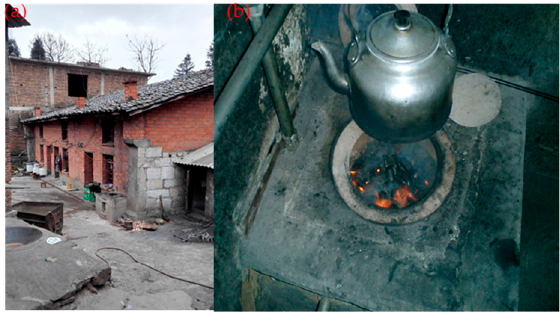
Figure 1. The stove ( a ) and building structure ( b ) in rural Xuanwei, China.